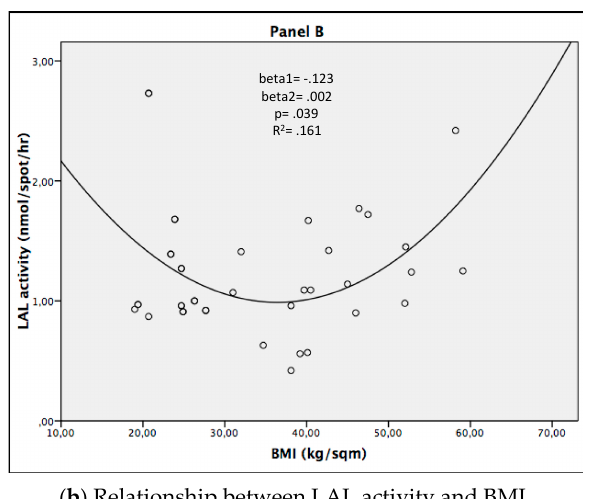
Figure 3. Quadratic relationship of LAL activity with body weight and BMI.